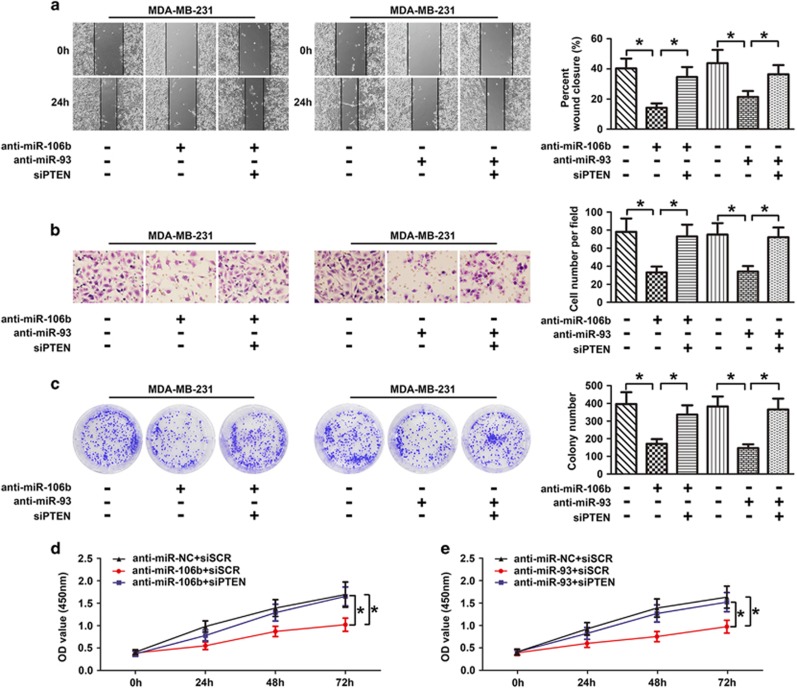
Reductive miR-106b or miR-93 targeted PTEN to attenuate cell progression in MDA-MB-231 cells. (a-e) MDA-MB-231 cells were co-transfected with anti-miRNA (anti-miR-NC, anti-miR-106b or anti-miR-93) and the target mRNA (siSCR or siPTEN). The influence from anti-miR-106b or anti-miR-93 was reversed by downregulation of PTEN in MDA-MB-231 cells. Representative results of wound-healing assay (a), transwell assay (b), colony formation assay (c) and CCK8 assay (d and e) in MDA-MB-231 cells. Each experiment was independently repeated at least three times. Data were presented as mean±S.D. (*P<0.05)